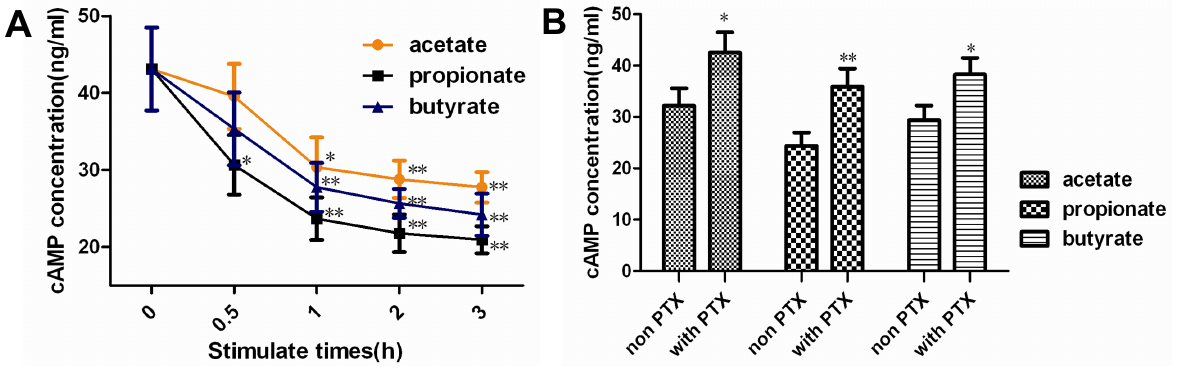
Figure 2. The effect of SCFAs on the intracellular cAMP levels in DCAPCs. DCAPCs were treated with 1.0 mmol/L acetate, propionate, and butyrate for 0, 0.5, 1.0, 2.0, and 3.0 h, respectively ( A ); The cells were also treated with or without prior PTX incubation (100 ng/L) for 2 h, and then stimulated with 1.0 mmol/L acetate, propionate, or butyrate for 3 h, respectively ( B ). Each treatment replicated 12 times. * p < 0.05, ** p < 0.01 vs. the control group.